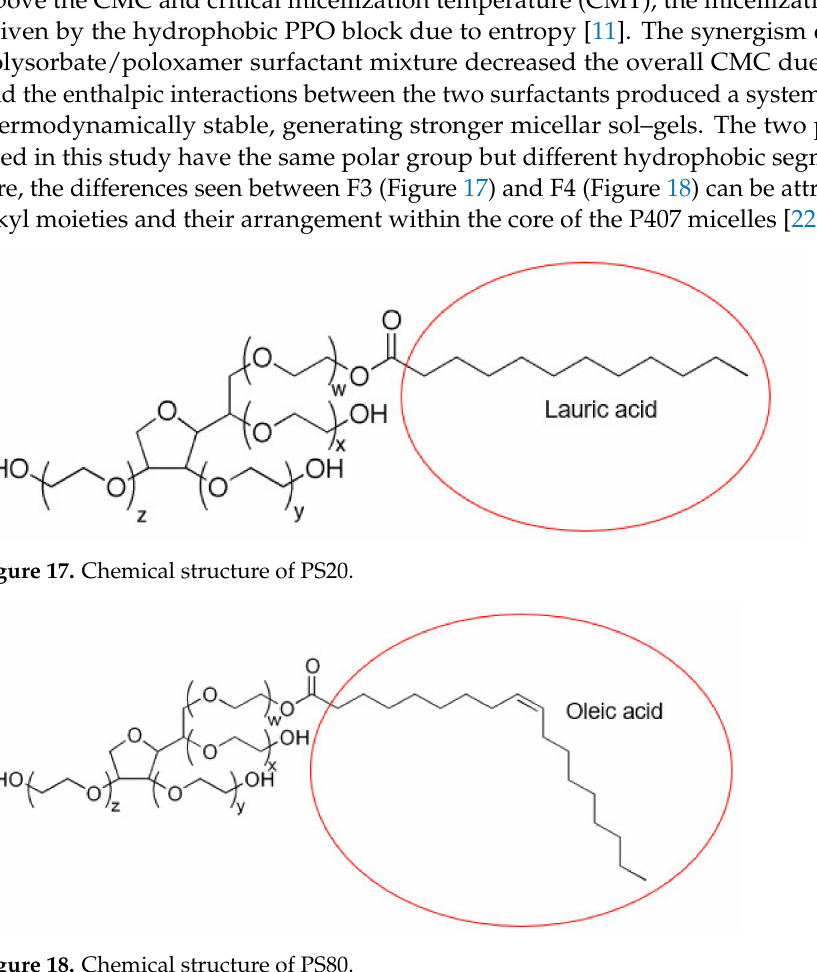
Figure 18. Chemical structure of